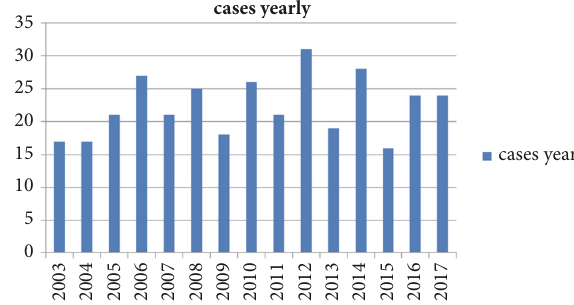
Figure 2: Number of BCC new cases over 15 years: